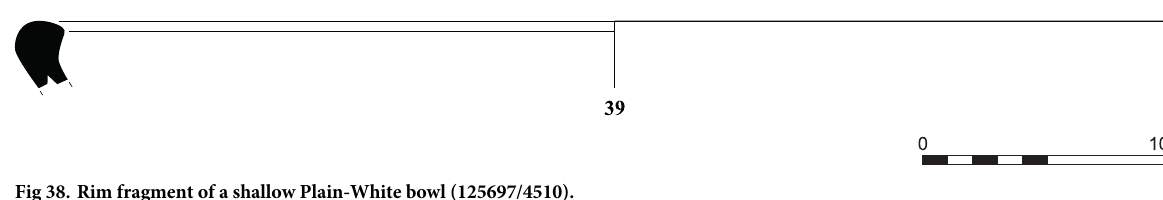
Fig 38. Rim fragment of a shallow Plain-White bowl